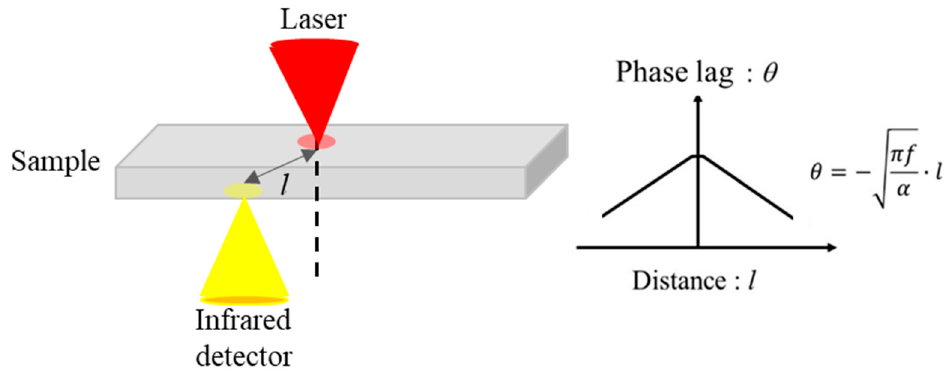
Figure 1. Schematic of the thermowave analyzer (TA) based on the spot periodic heating and infrared radiation thermometer method.